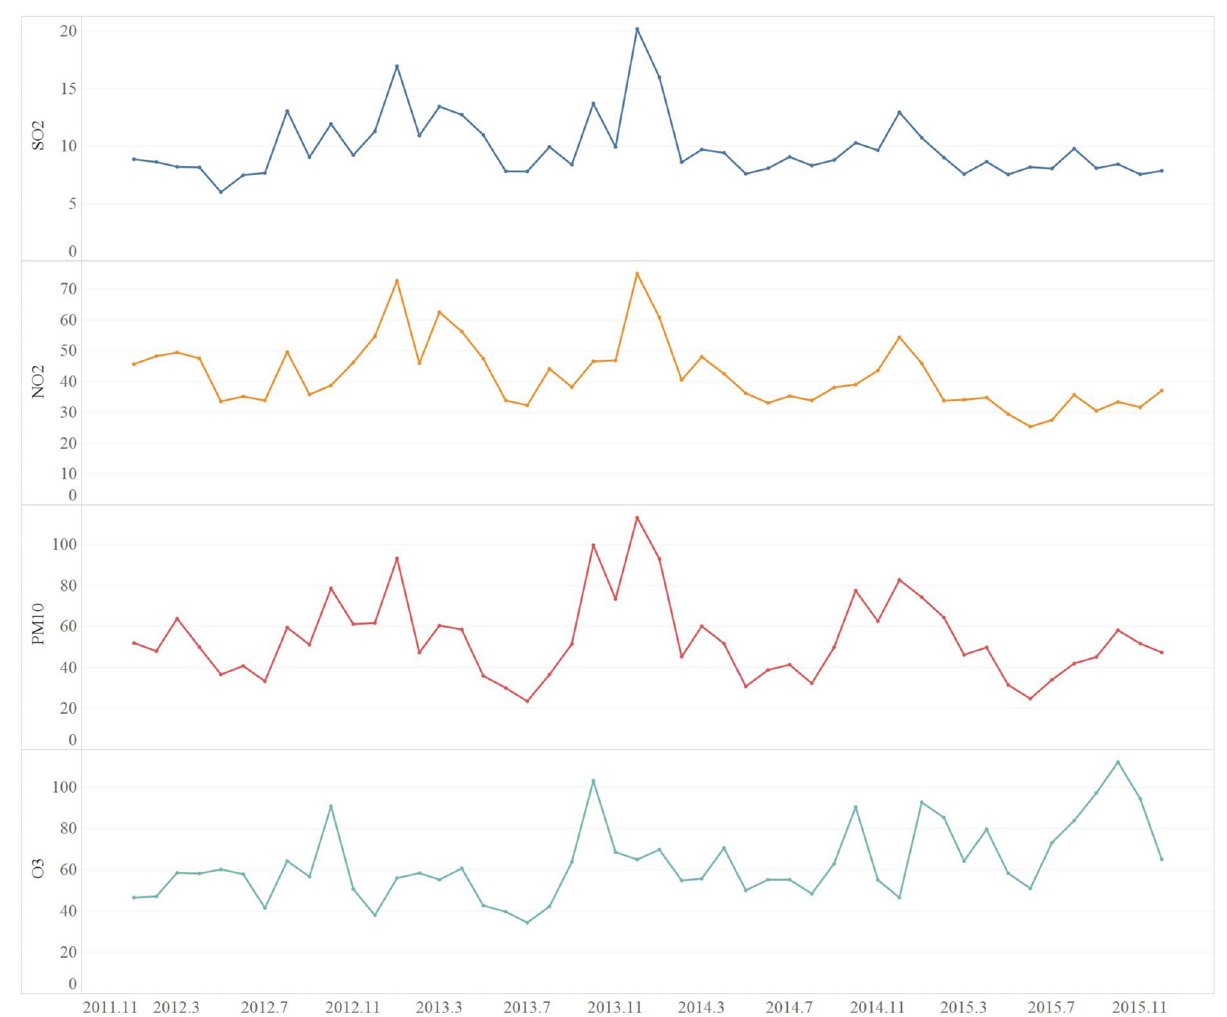
Fig 3. The variation of the pollutant over the 4 years, from 2012 to